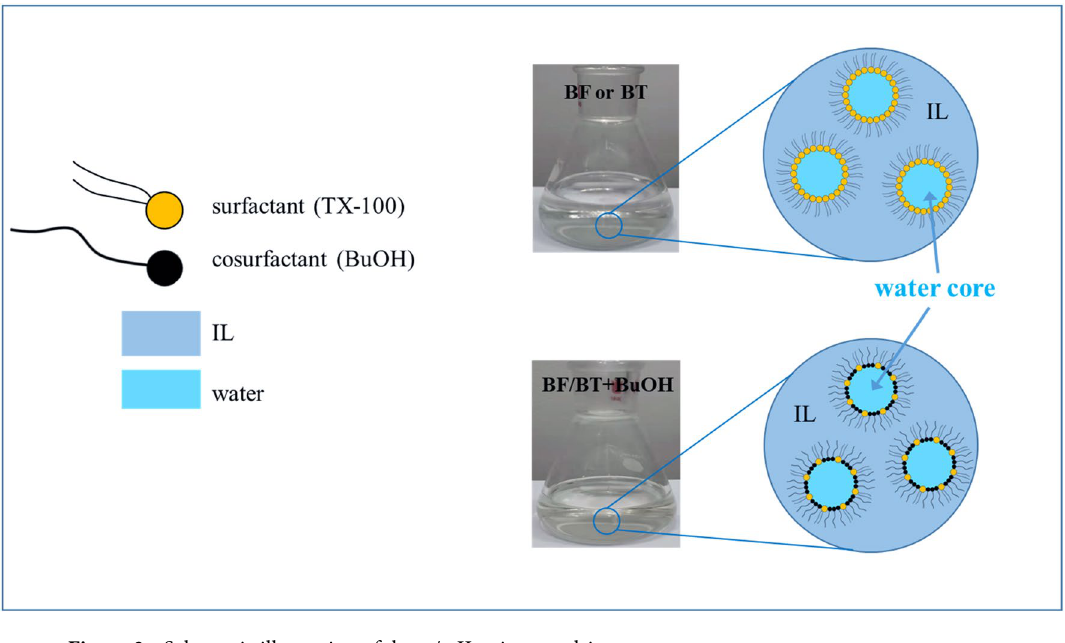
Figure 3. Schematic illustration of the w/o IL microemulsion structure.